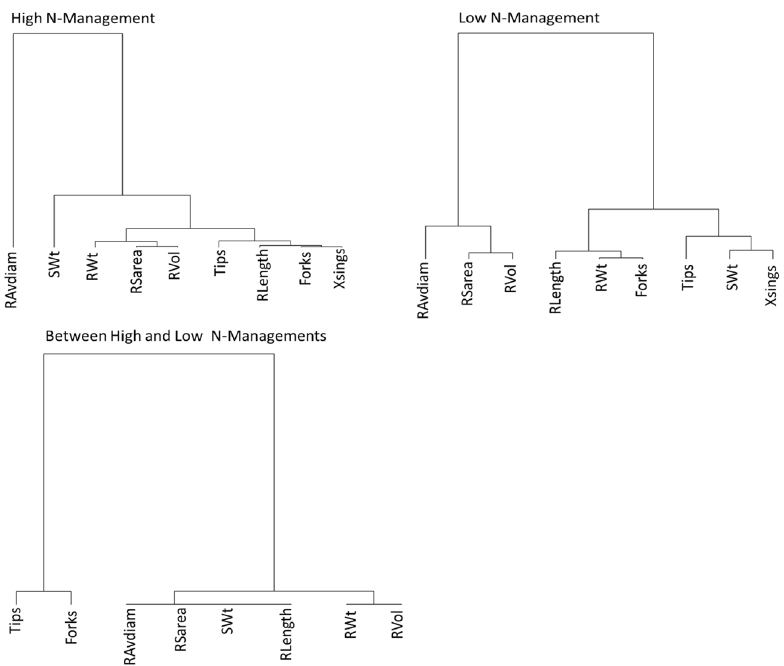
Figure 3. The structure of genetic correlations between traits within and between the two N-managements. Ward method was used to construct the dendrograms. In the correlations between N-Managements, Xsings is missing because its heritability was < 0.1 threshold we had set when calculating the genetic correlation